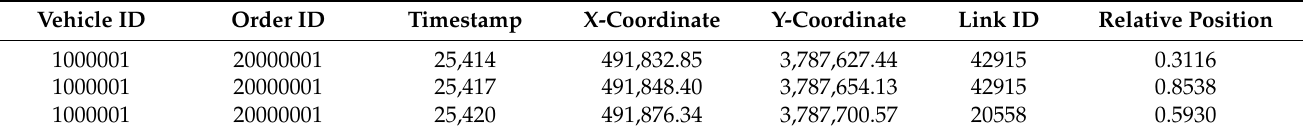
Table 1. Data section after